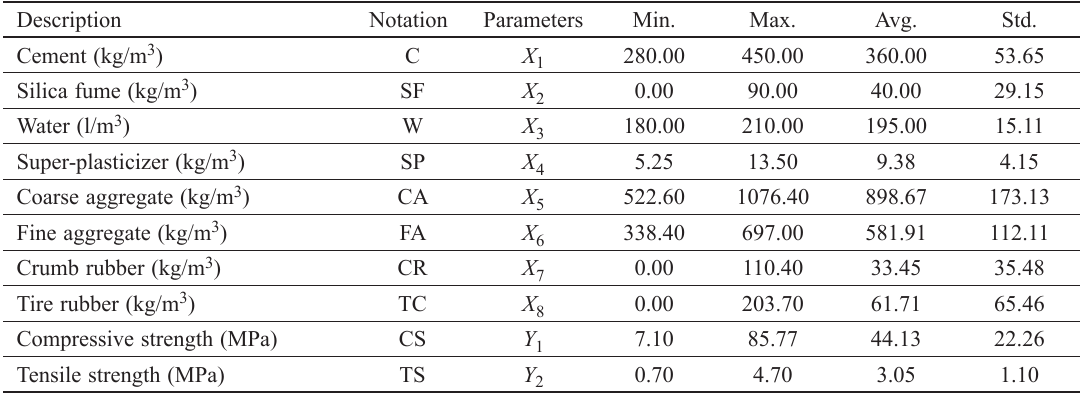
Table 1. Input and output parameters